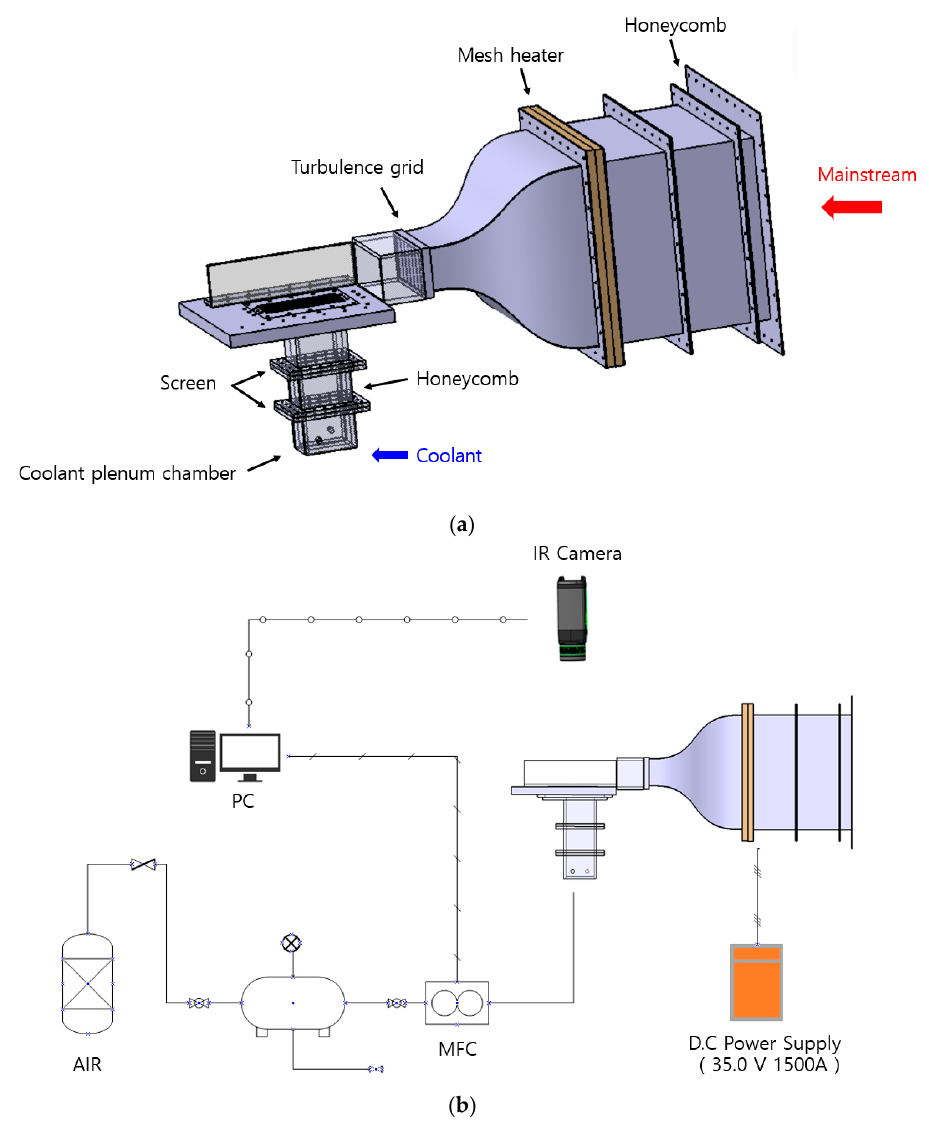
Figure 1. Experimental facility: ( a ) overview of test facility; and ( b ) schematic of experimental setup.